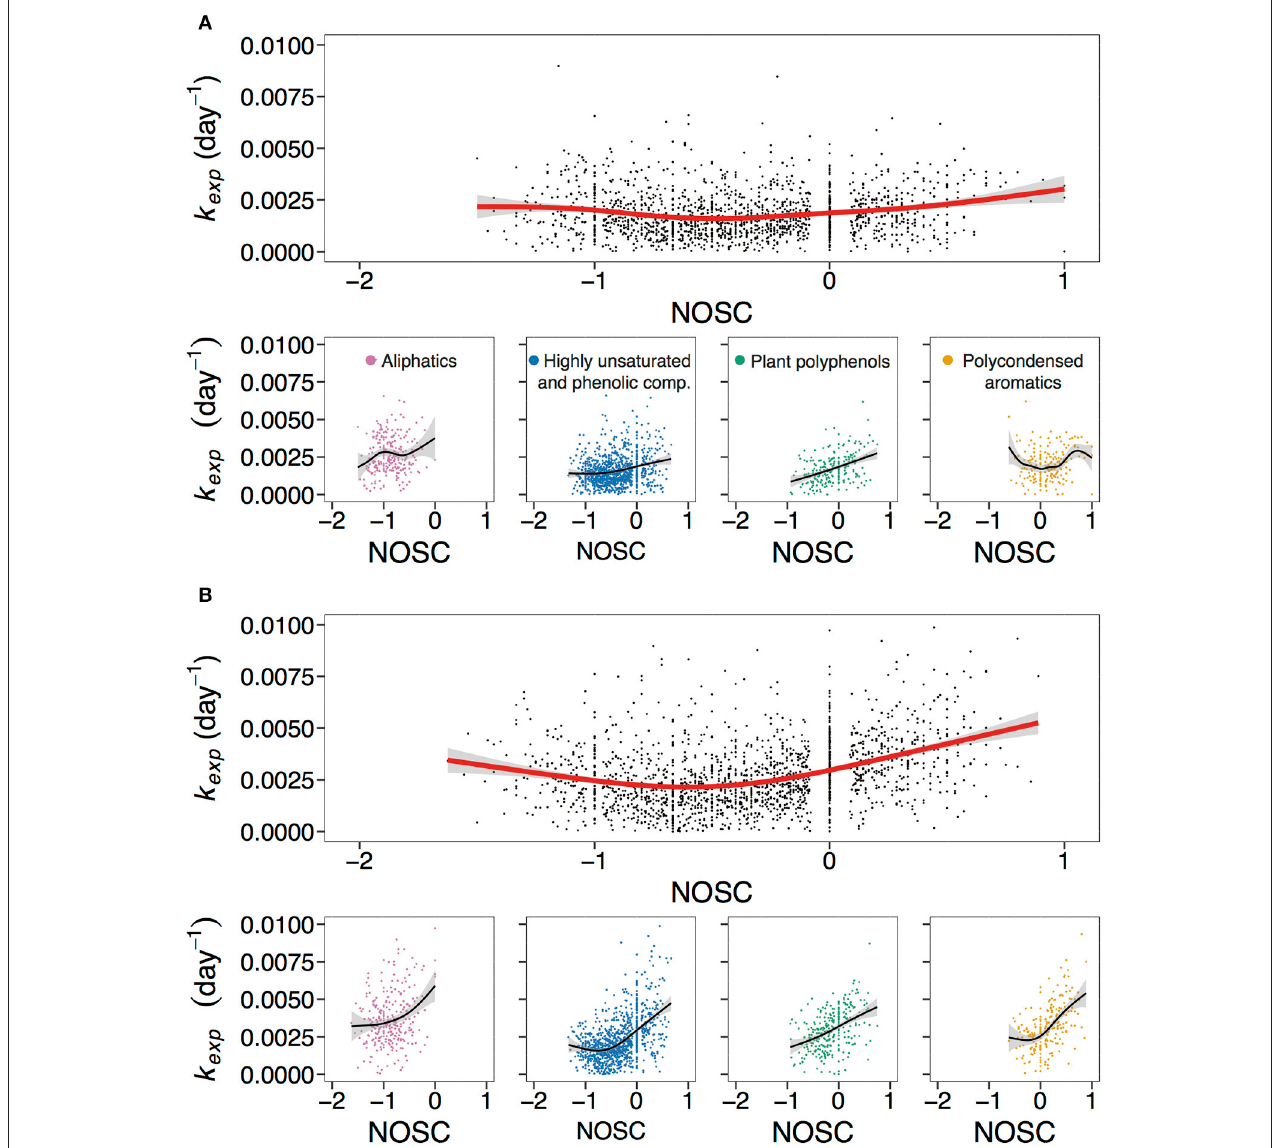
FIGURE 4 | Overall and compound group-specific relationship of k exp with nominal oxidation state of carbon (NOSC). (A,B) correspond to non-manipulated and UV-manipulated treatment, respectively. Red and black lines correspond to fitted generalized additive models (GAM). The data is shown for one of the duplicates of lake Ramsjön (data for the second duplicate and two other lakes is shown in the Figure S6). Color-coded are aliphatics (pink), highly unsaturated and phenolic compounds (blue), plant polyphenols (green), and polycondensed aromatics